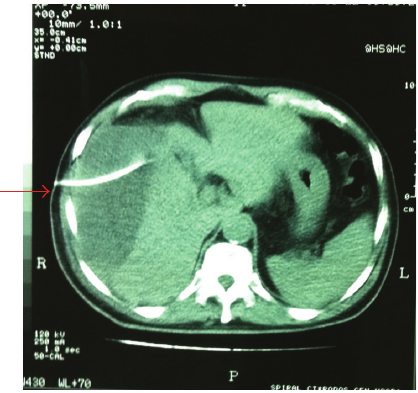
Figure 3: Percutaneous drainage of the collection under CT guidance